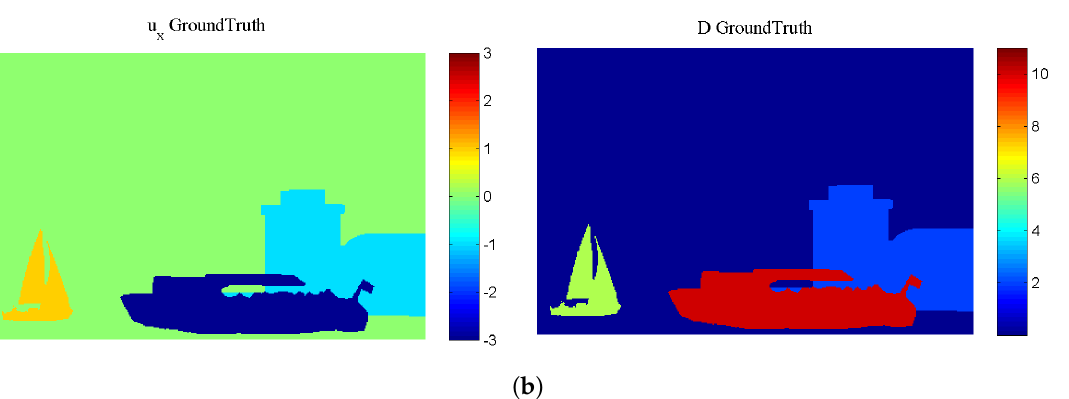
Figure 3. Artificial “Futuristic White-Tower” sequence: ( a ) first and last (sixth) frame of the Left view; ( b ) ground-truth horizontal speed and disparity.